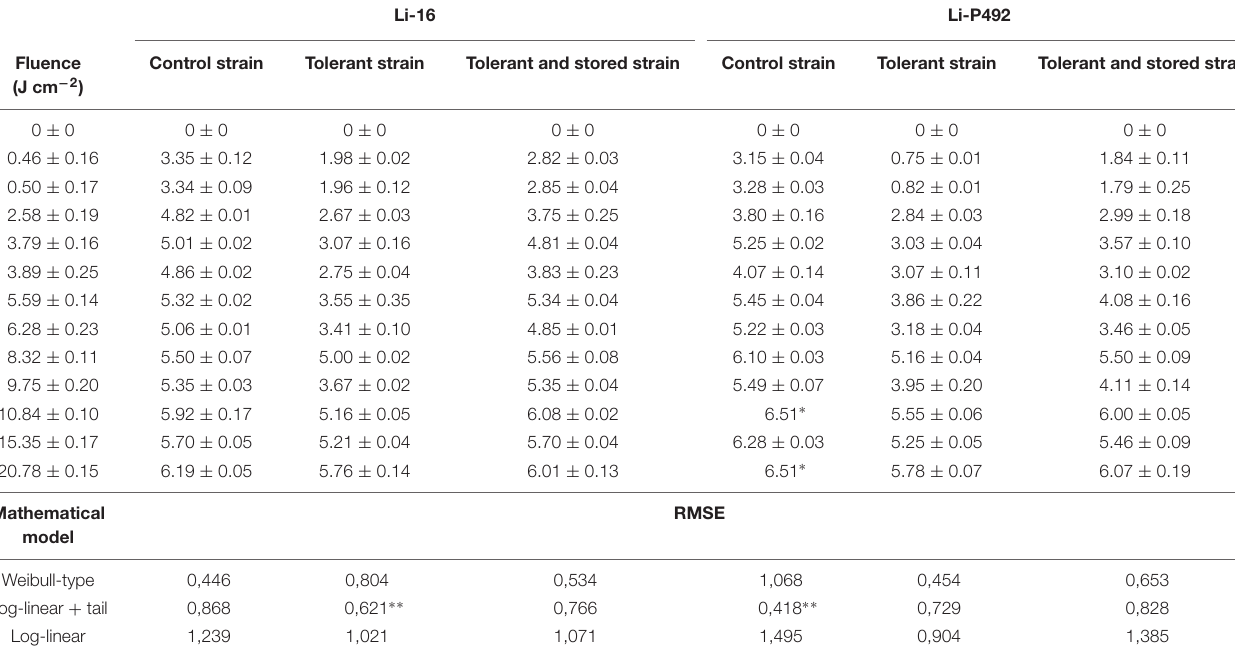
TABLE 4 | Mean reduction (log CFU cm − 2 ) of viable counts of L. monocytogenes Li-16 and Li-P492 on Tryptone Soya Agar supplemented with Yeast Extract when exposed to different PL treatment